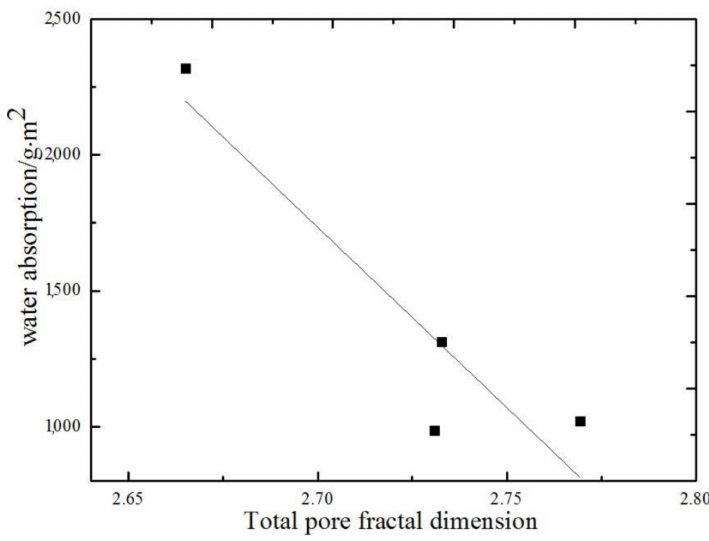
Figure 13. Relationship between water absorption values and total pore dimension (28 days cured concrete).